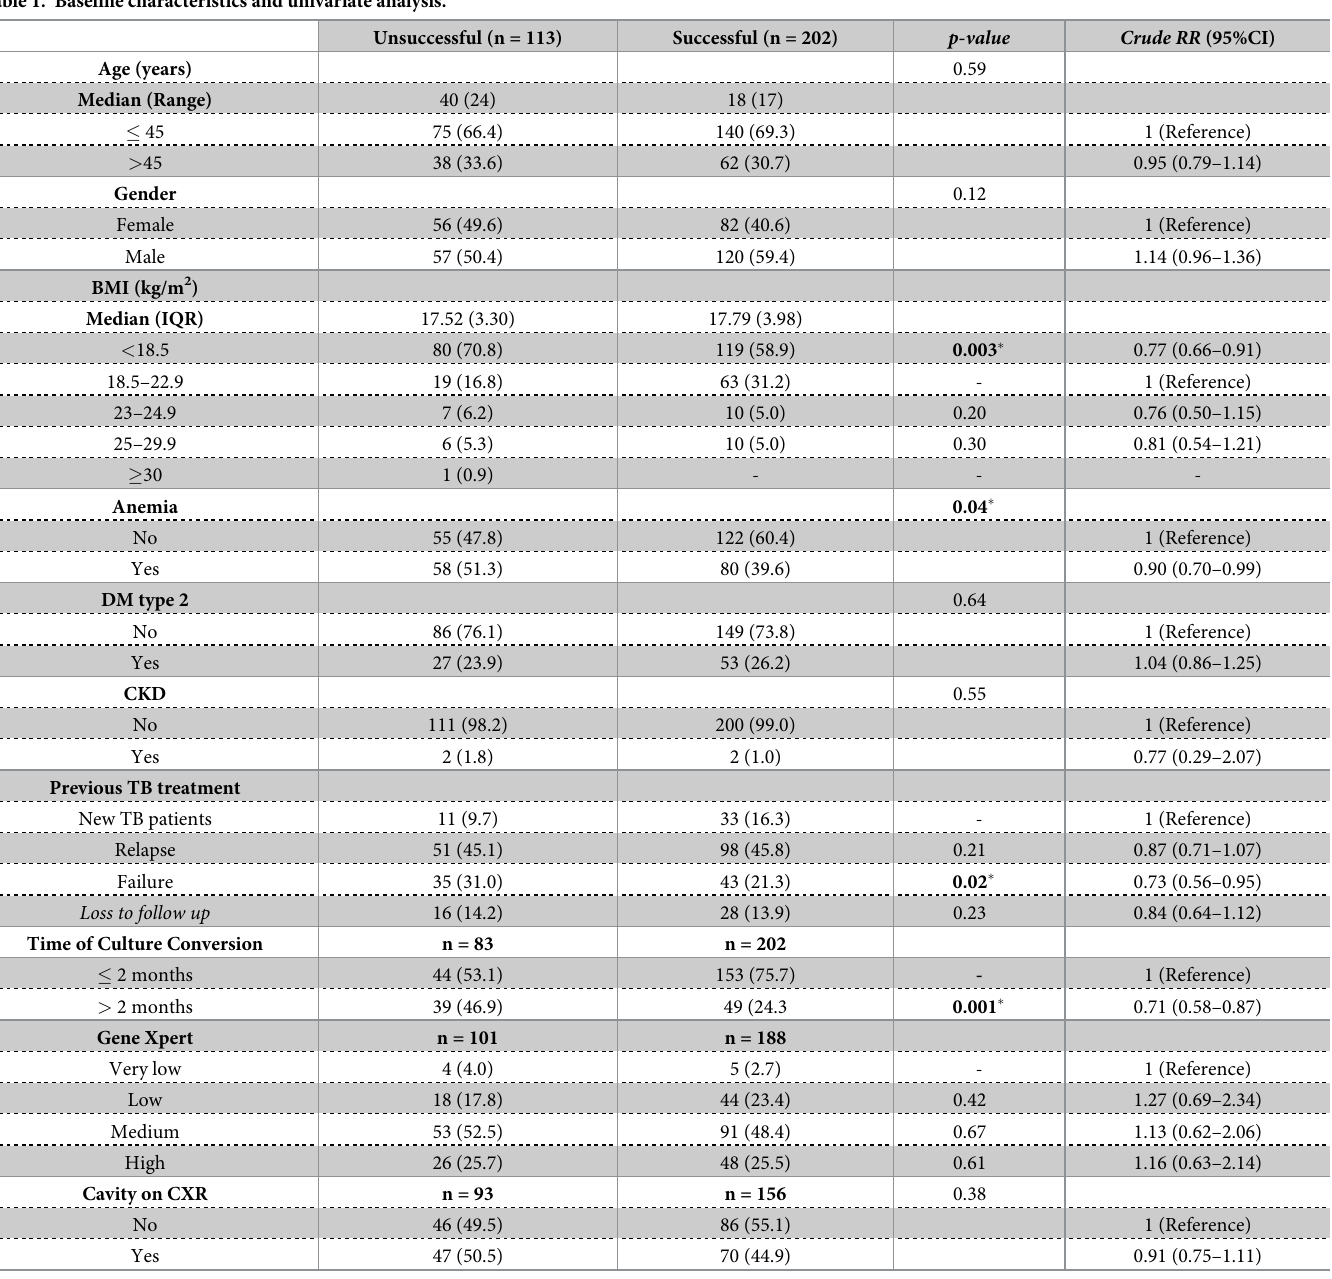
Table 1. Baseline characteristics and univariate